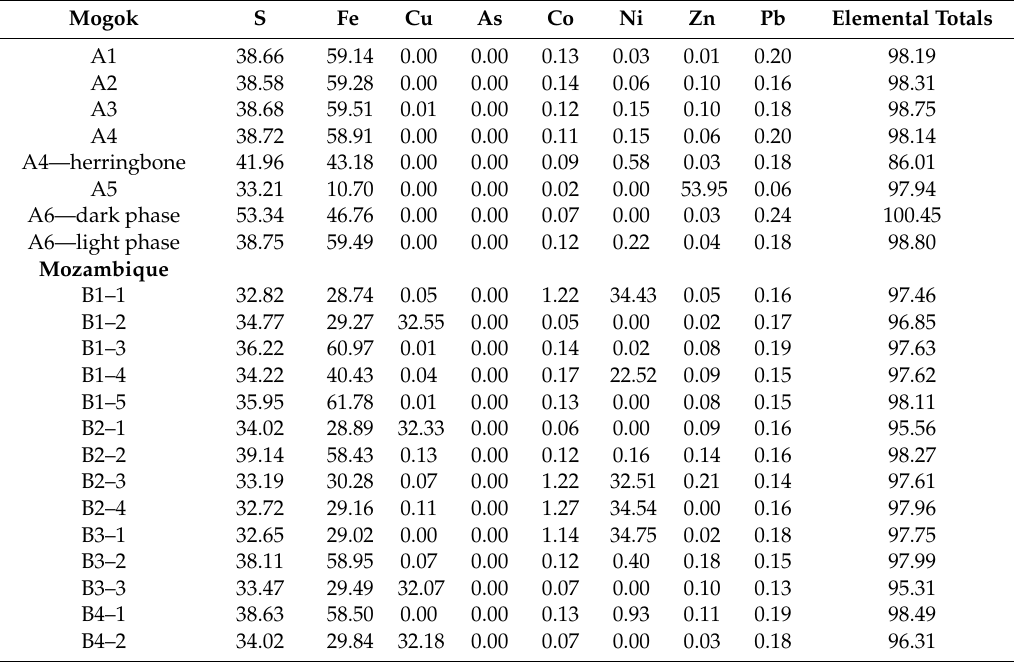
Table 3. EPMA results: Elemental percentages and the elemental